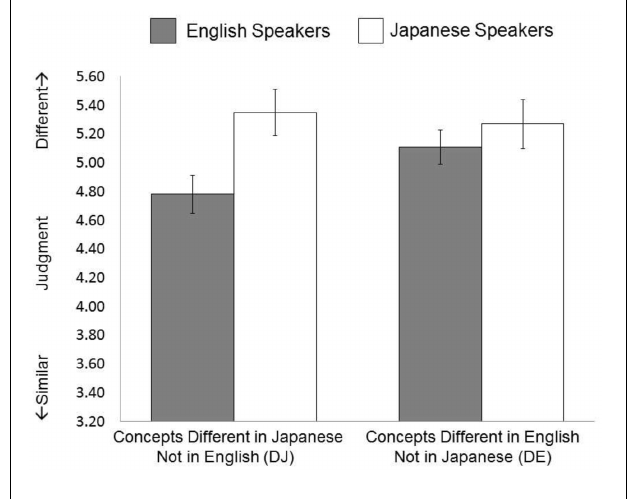
FIGURE 4 | Results of Study